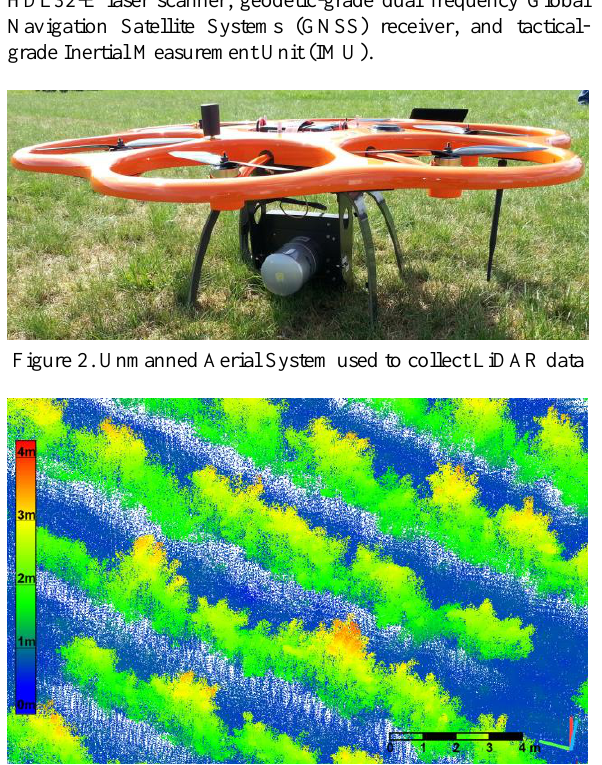
Figure 3. Plot of the point cloud obtained for a part of the study area; height coded with